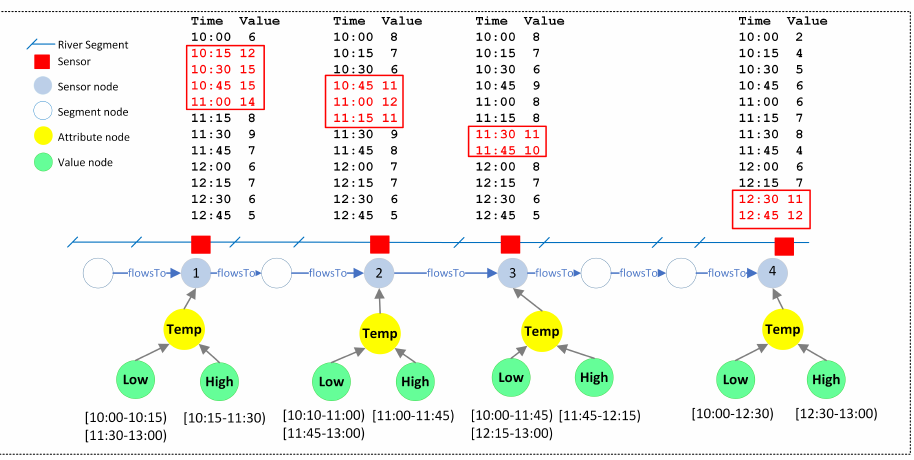
Figure 7. River Network Flow Path for Temperature = High